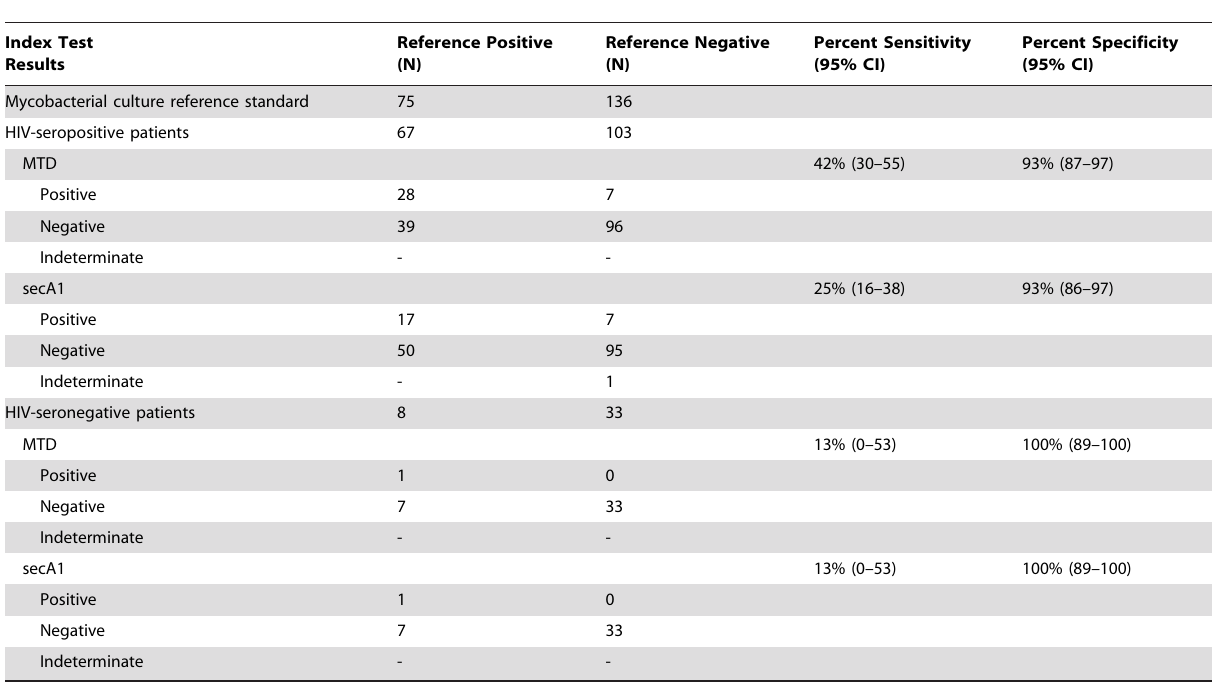
Table 3. Diagnostic performance of nucleic acid amplification tests for TB stratified by HIV status, compared to the primary reference standard